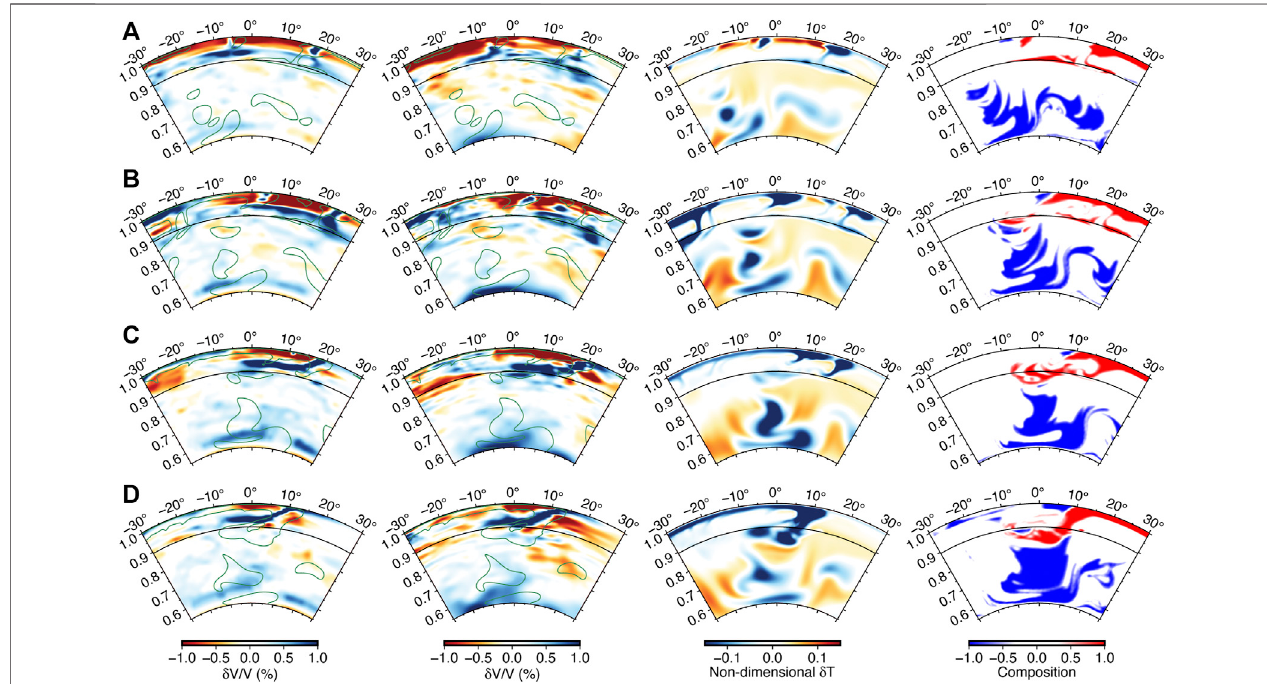
FIGURE 2 | Cross-sections of P-wave velocity perturbations from seismic tomography models TX2019slab ( fi rst column) (Lu et al., 2019) and GAP_P4 (second column) (Fukao and Obayashi, 2013), and the present-day non-dimensional residual temperature (third column) and composition (last column) from numerical model case 1. The black linein each cross-section corresponds to the 670-km depth. The locations of (A – D) correspond topro fi les P1-P4 as shown in Figure 1 , respectively. In fi guresoftomographymodels(i.e., fi rstandsecondcolumns)thegreenlinesindicatecontoursofnon-dimensionalresidualtemperature δ T of −